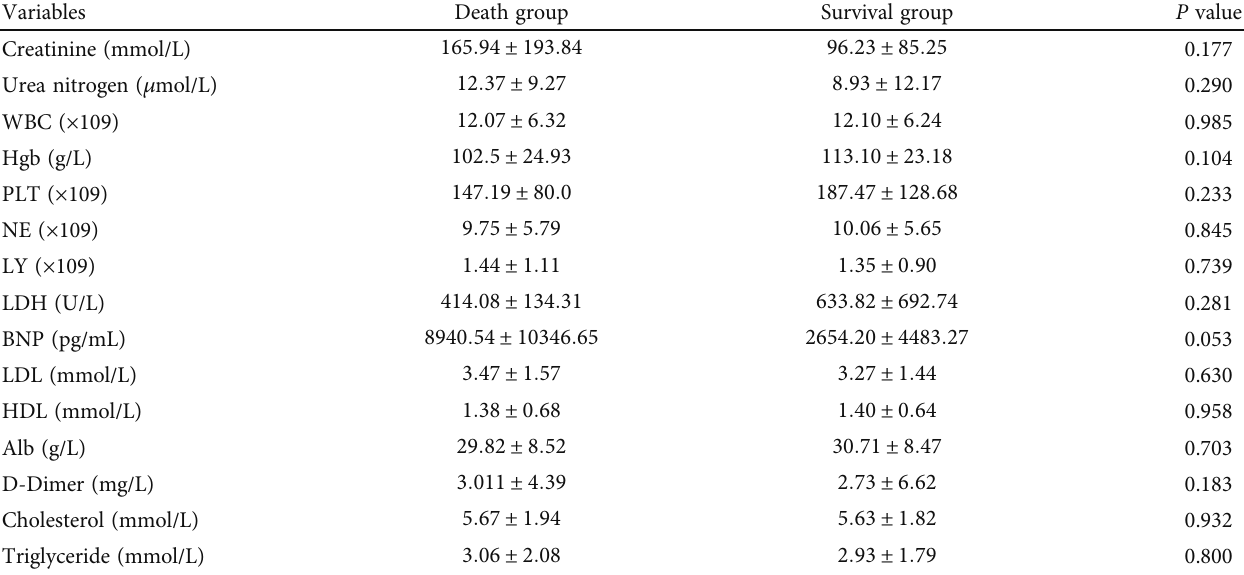
Table 3: Comparison of laboratory data.